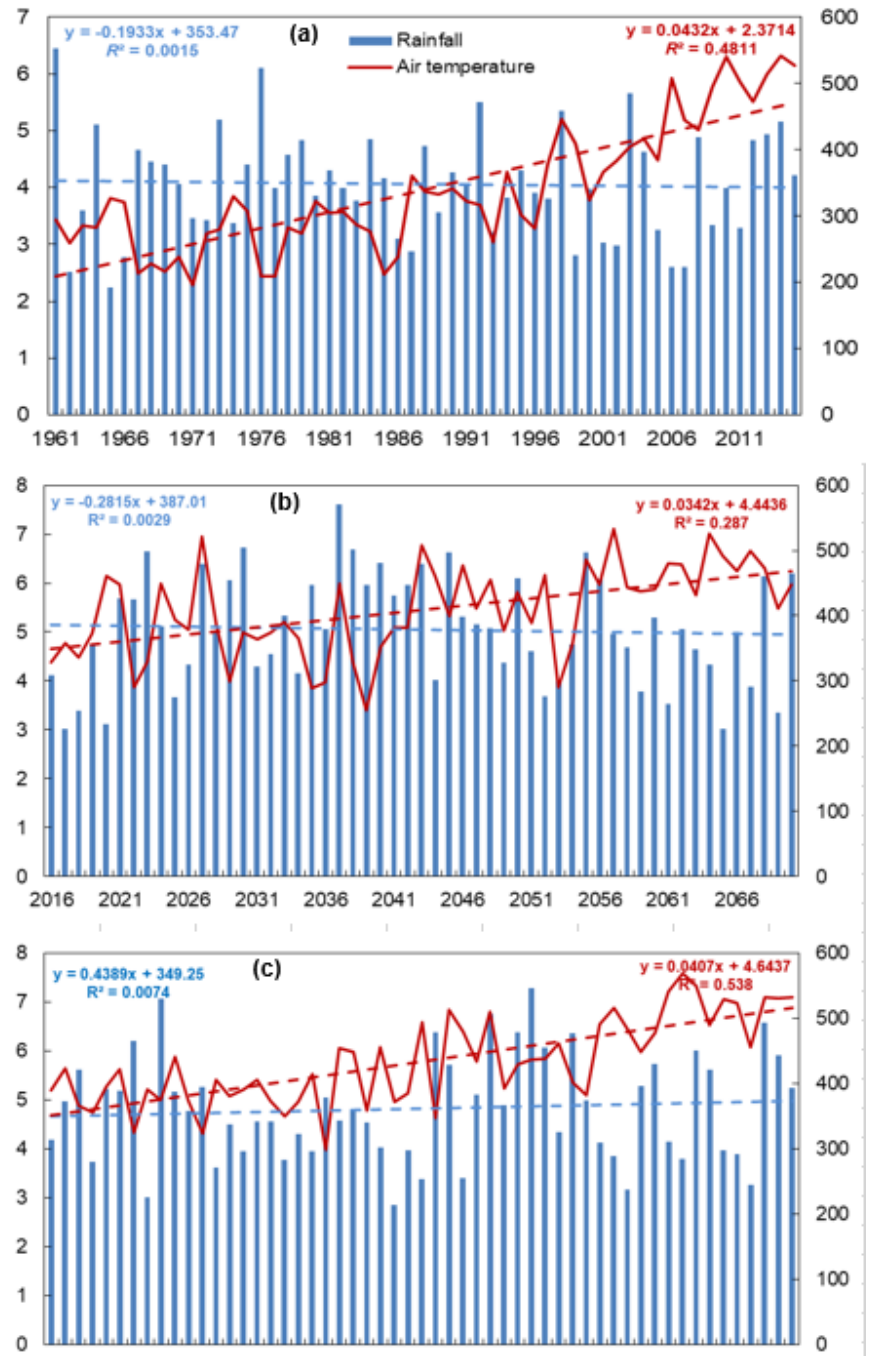
Figure 2. Quantification of climate warming trends ( a ) during the observed years, and two future scenarios: ( b ) RCP4.5, and ( c ) RCP8.5 for annual mean daily air temperature and annual rainfall in Punjab, values of R 2 in red indicate significance at p < 0.01. Intercepts represent the value during the first year of the time series, i.e., in figure ( a ) x = 1961 and in ( b ) x = 2016, and ( c ) x = 2016. The yearly variation is represented in the slopes (where p = 0.43).